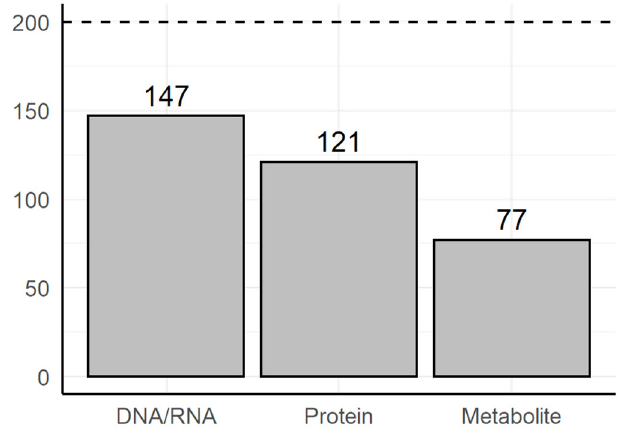
Figure 4. Results of the manual review of 200 text fragments in each category.